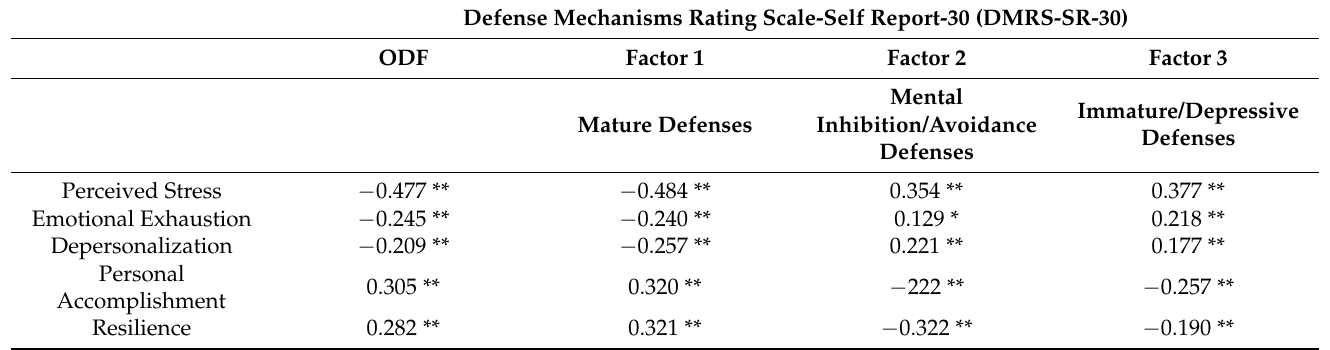
Table 3. Pearson correlations between psychological variables tested in health care professionals at the time of COVID-19 ( N = 233).